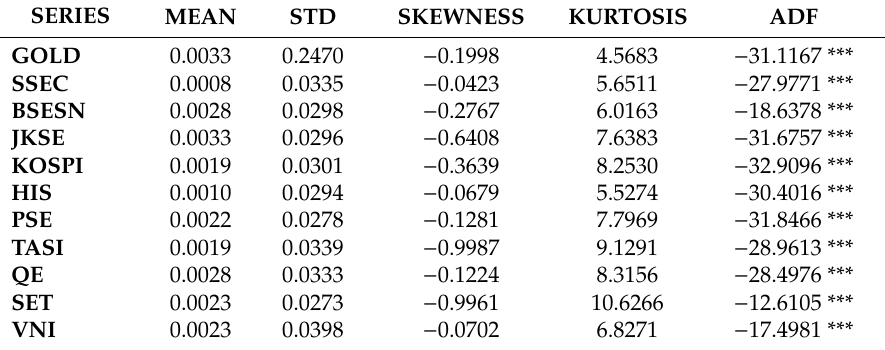
Table 1. Descriptive statistics of the weekly return of the stock market and